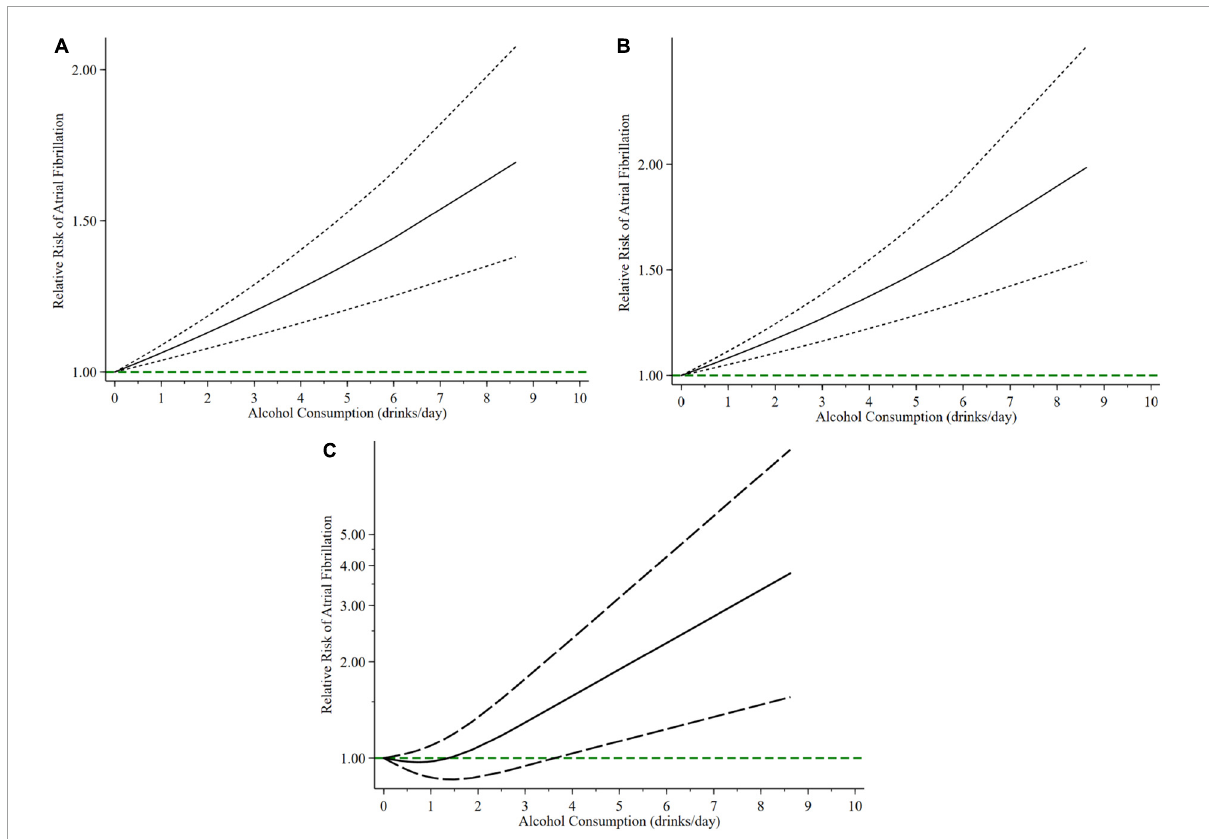
FIGURE6 The relationship between relative risks of atrial fibrillation with different alcohol consumption. Continuous line shows non-linear association and long-dashed lines depict 95% confidence intervals. (A) In total; (B) men; (C)